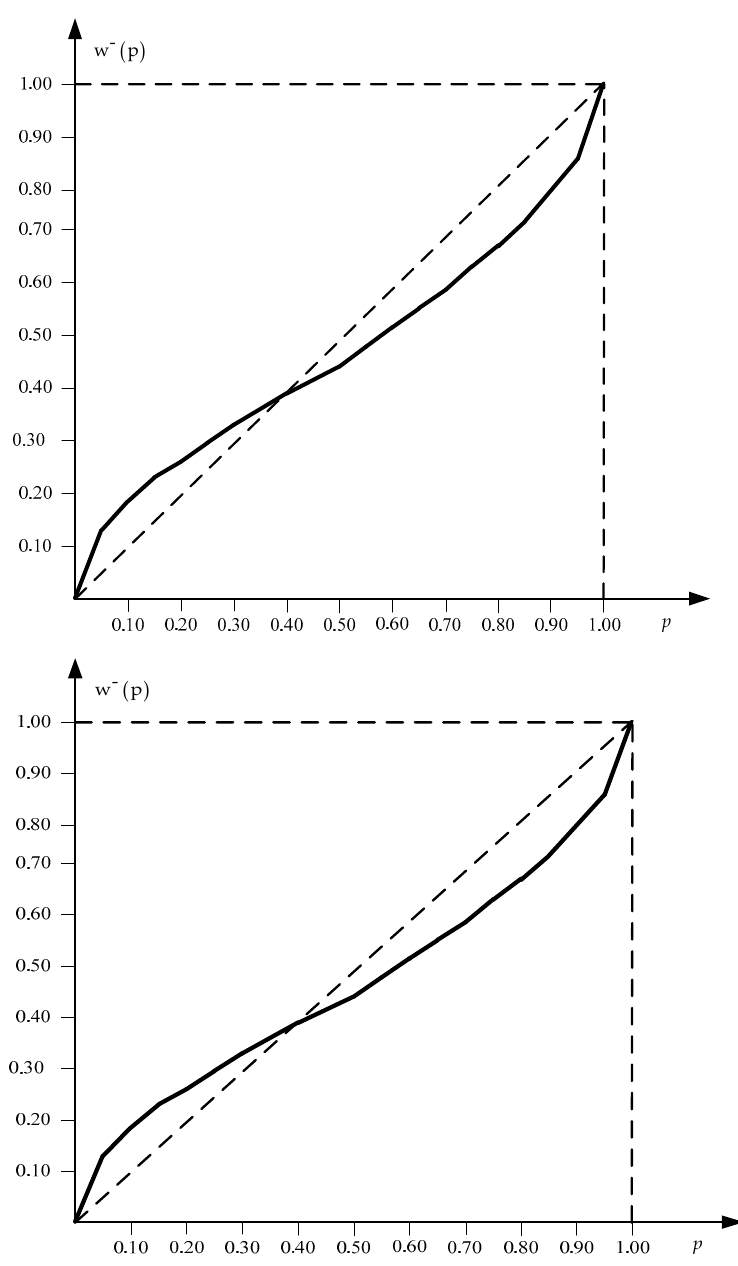
- + w (p) , by expressions (12), (13). Figure 4. Graphs of probability weighting functions w + ( p ) , w − ( p ) , by expressions (12), w (p) ,